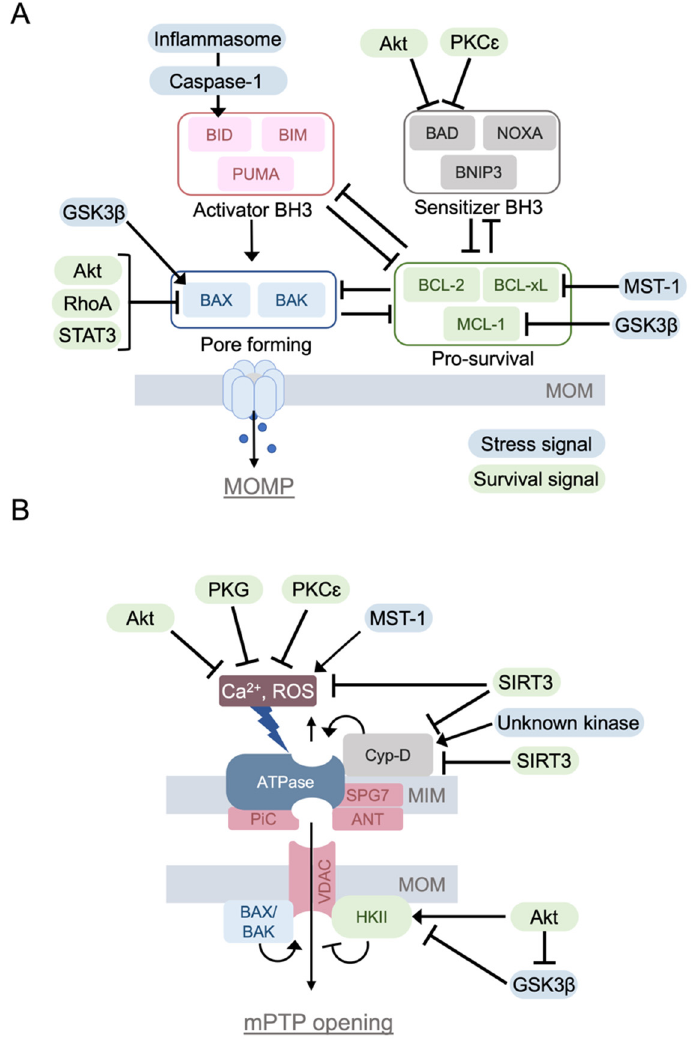
Figure 2. The BCL-2 family proteins and the mitochondrial permeability transition pore (mPTP). ( A ) BCL-2 family proteins regulate mitochondrial outer membrane permeabilization to induce apoptotic cell death, which is positively and negatively regulated by intracellular signaling molecules. ( B ) mPTP is a large conductance channel that is activated by Ca 2+ overloading and ROS, inducing the rupture of mitochondrial membranes and eventual cell death. Although the molecular constituents of the mPTP continue to be disputed, it has been shown that the opening of the mPTP is regulated by intracellular signaling molecules.